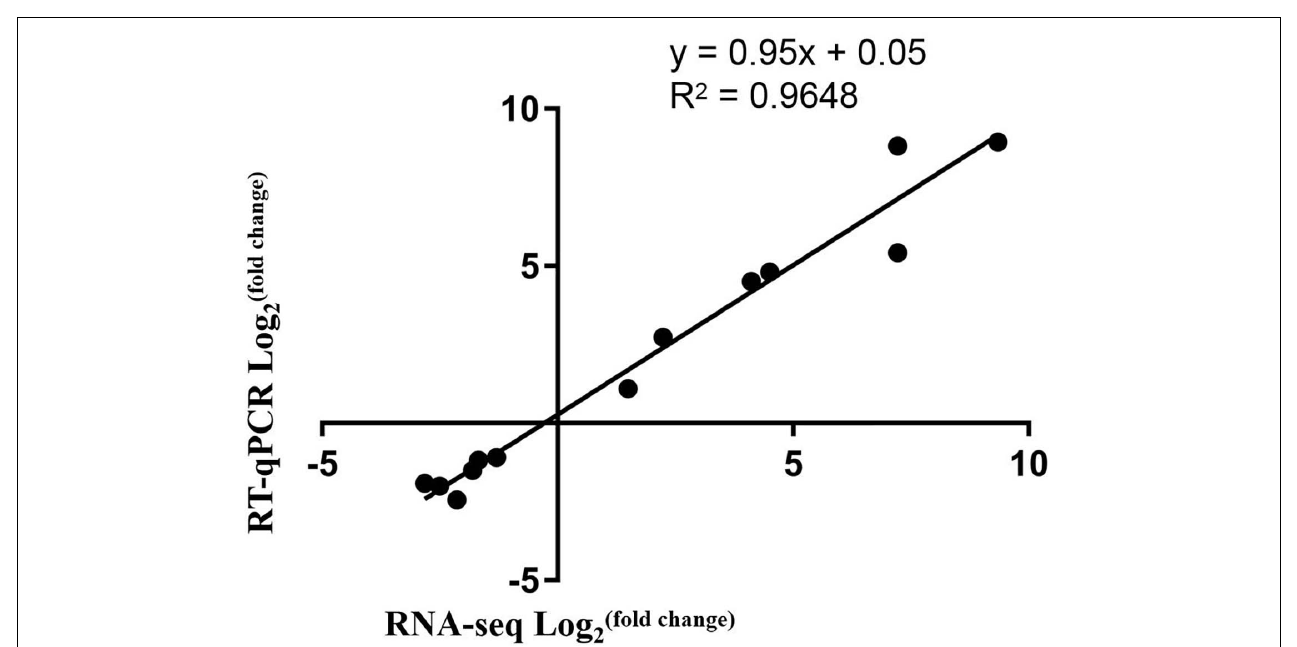
FIGURE 6 | Correlation of expression levels between RNA-Seq and